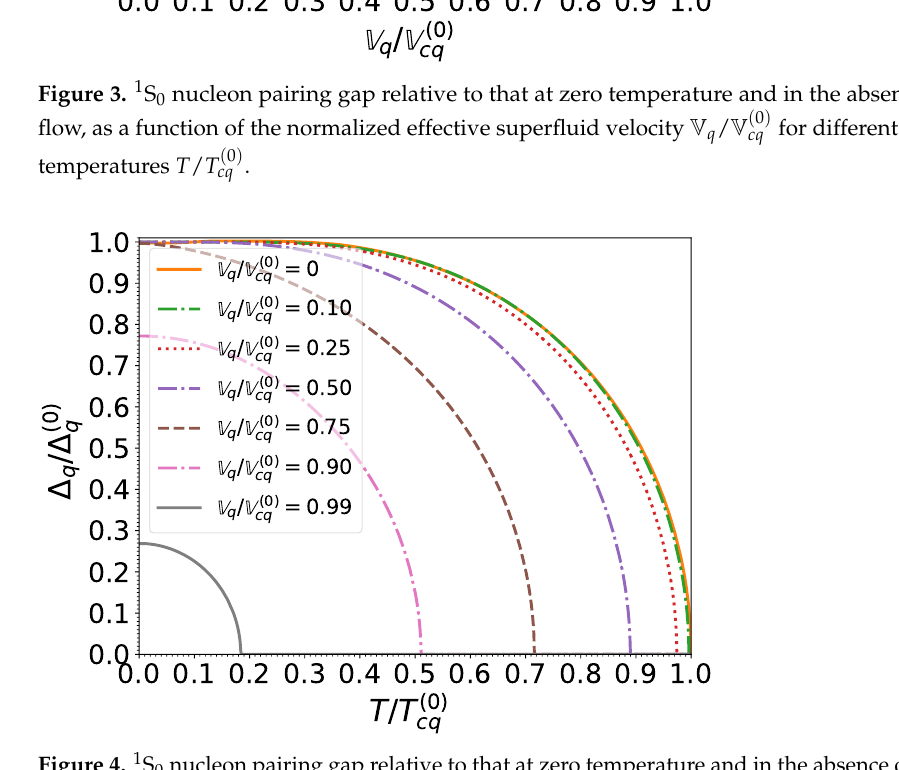
( 0 ) cq for different normalized effective superfluid